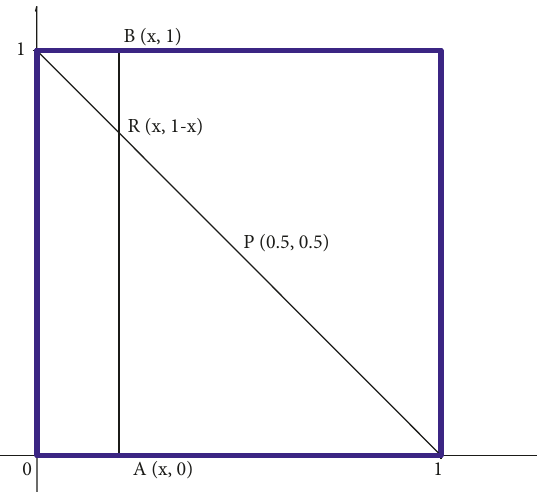
Figure 5: Relationship between Yang value and Yin value in the right-angle